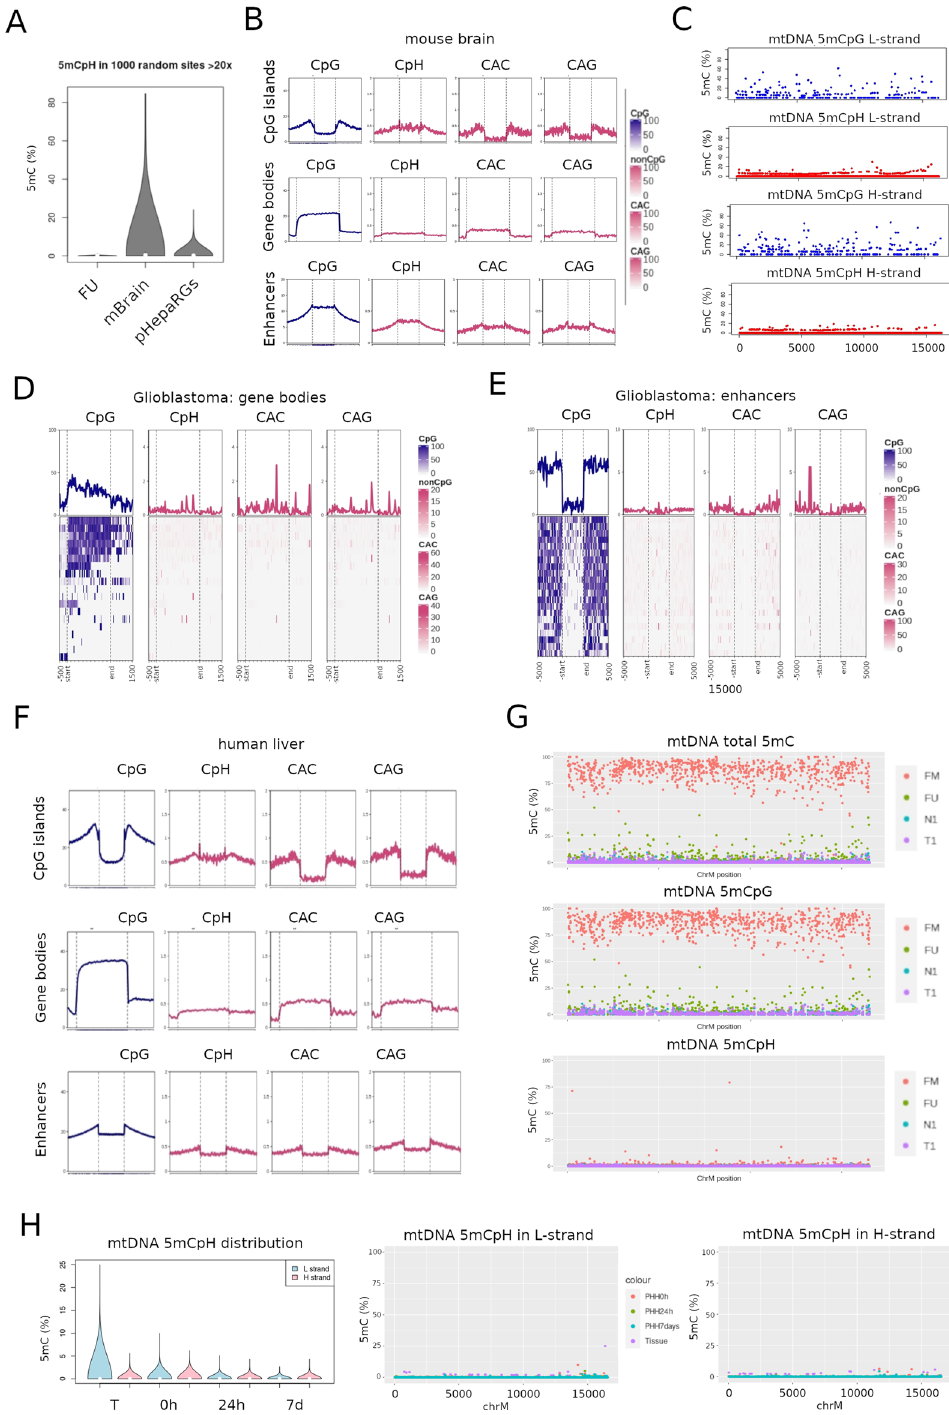
Figure 6. NonCpG methylation using nanopore single molecule sequencing. Raw data (fast5) from different samples and conditions was basecalled using an all-context 5mC neural network model. ( A ) 5mC distribution in non-CpG (CpH) context comparing fully unmethylated control (FU), one mouse brain sample (mBrain) and the proliferative HepaRG cell line (pHepaRG). ( B ) Total (nuclear DNA) 5mC information from the mouse brain sample was aggregated to create enriched heatmaps according to mm10 annotated CpG islands, gene bodies and enhancer regions. Average methylation plots are shown for CpG, CpH, or specifically for CAC and CAG context. ( C ) Mitochondrial DNA methylation (% 5mCpG) in the same mouse brain sample, presented by strand (L-strand : top plots, H-strand: bottom plots) and cytosine context (CpG: blue, CpH: red). ( D ) Similar analysis was done in cas9-targeted data of human glioblastoma cell lines and tissues 53 . Combined 5mC data (6 human diffuse gliomas and 3 human glioblastoma cell lines) was aggregated according to ( D ) gene bodies, and ( E ) enhancers. ( F ) Similar to ( A ), we performed all context 5mC base calling in a human liver sample, and aggregated the data according to genomic context. ( G ) The same liver sample shown in ( F ) was used to extract reads aligning to mtDNA (N1). A matched tumor sample (T1) and FM/FU controls are also shown in separate plots for total 5mC (top panel), 5mCpG (middle panel) and 5mCpH (bottom panel). ( H ) 5mCpH values corresponding to the PHH kinetic experiment described in Fig. 5. Genomic 5mCpH distribution is shown in ( H ) and mtDNA 5mCpH is shown in ( I ) separately for the L- (left panel) and H- (right panel)